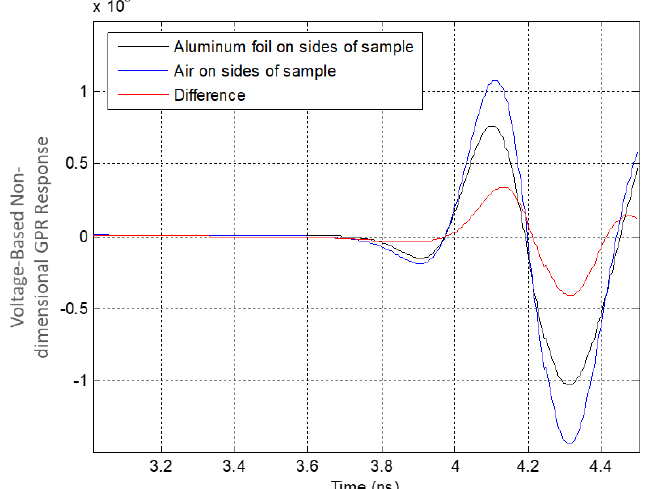
Figure 17. Comparison of isolated reflection differences from scans obtain with and without aluminum foil wrapped around the sides of the sample.